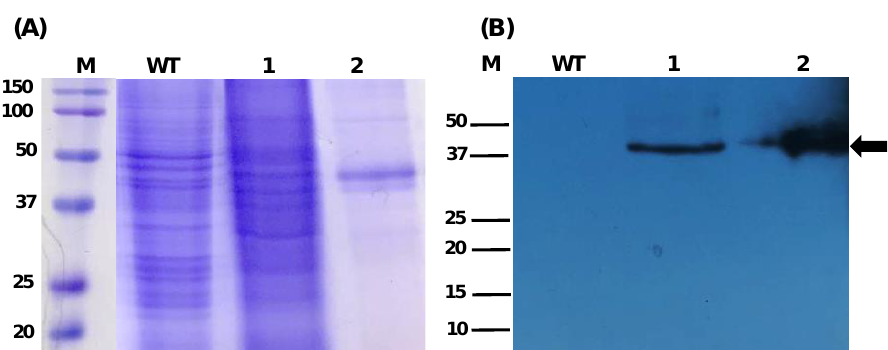
Figure 1. Stability of the RBD protein expressed transiently in C. reinhardtii . The total soluble protein (TSP) was extracted from dry biomass stored at room temperature for 15 months. ( A ) SDS-PAGE pattern of the TSP. Gel stained with Coomassie brilliant blue. ( B ) Western blot analysis labelled with anti-His tag antibody. Lanes; M: Molecular weight marker, WT: Wild-type, Lane 1: TSP from C. reinhardtii expressing RBD, Lane 2: RBD purified from N. benthamiana (6.5 µg) used as positive control.